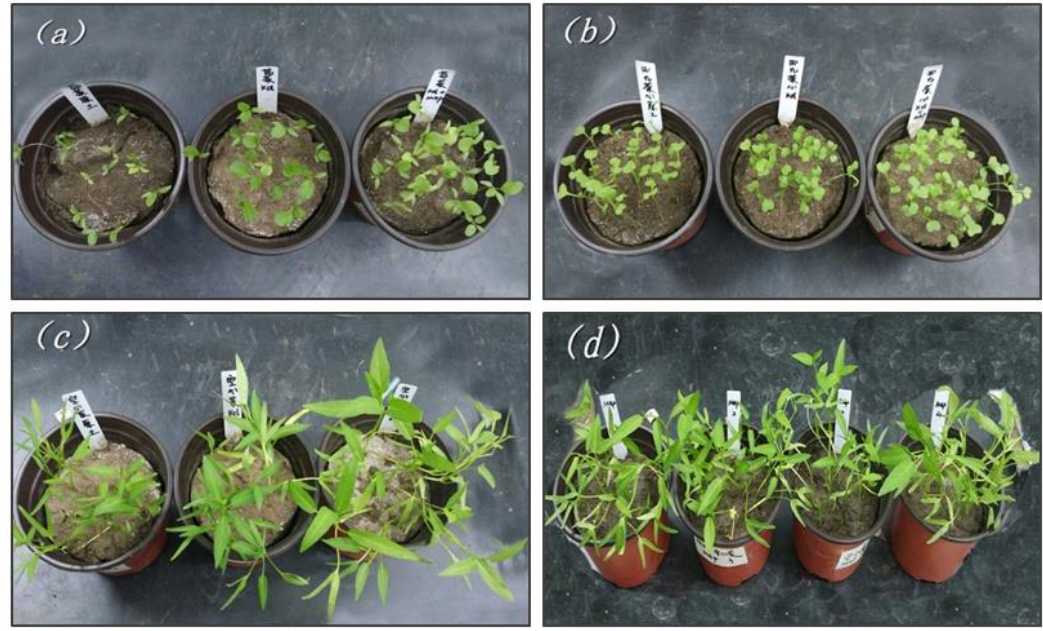
Figure 4. Photos of three vegetables at different cultivation condition after 35 days growth. (left, control pots; middle, KCl pots; right, MAP pots) ( a ) Amaranth. ( b ) Brassica parachinensis Bariley. ( c ) Swamp cabbage. ( d ) Gradient test of swamp cabbage. (From left to right: 1×, 2×, 3×, and 4× MAP).